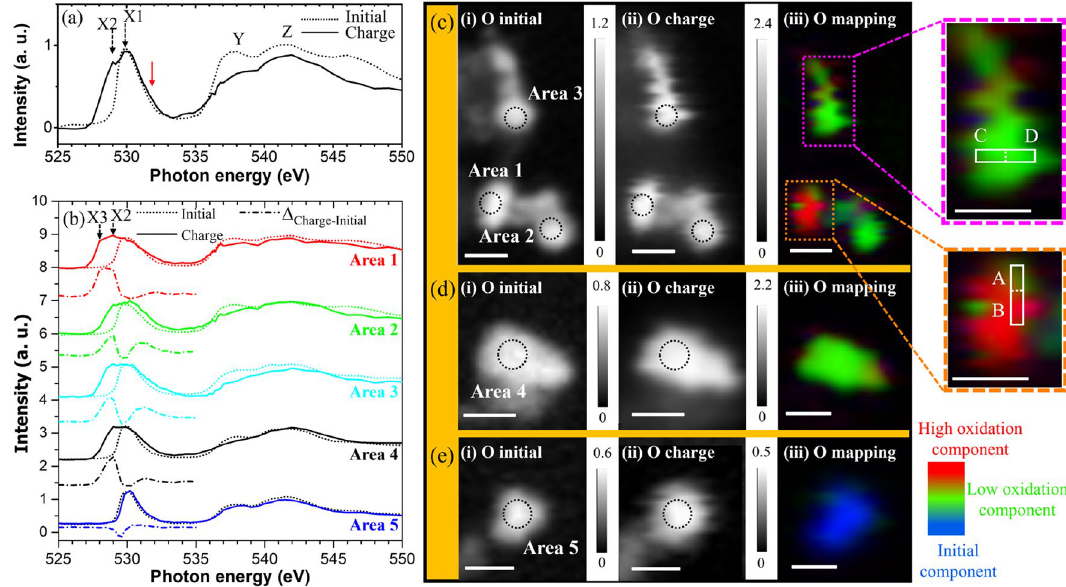
Figure 3. O K -edge XAS spectra of the initial (dotted line) and charged (solid line) states measured by STXM: ( a ) those averaged over all the particles and ( b ) those recorded at the circled areas (diameter: 300 nm) of different LiCoO 2 particles in ( c ), ( d ) and ( e ). Also contained in ( b ) are the difference spectra (dash-dotted lines, 525–535 eV). ( c – e ) STXM OD images of O K -edge of the LiCoO 2 particles obtained at the (i) initial and (ii) charged states, and (iii) stack mappings (525–550 eV) shown by red, green, and blue colors, each indicating the charged states assigned using the reference spectra (solid lines) of Areas 1 and 2, and the initial state assigned according to the reference spectrum (dotted line) recorded at Area 5 shown in ( b ). Enlarged rectangular regions (A, B, C, and D) separated by dashed lines are shown on the right. The red and green colors represent different oxidation states. All the OD images of O are plotted at 529 eV, and the white scale bars represent 0.5 μm.